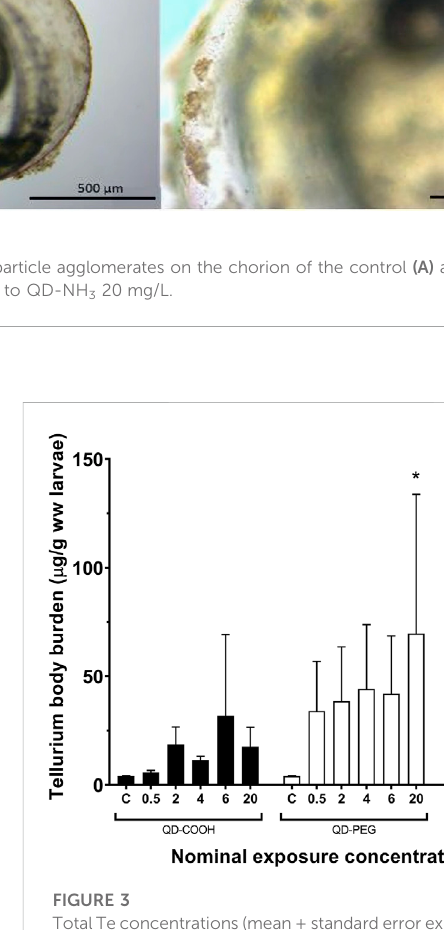
FIGURE 2 TotalCdconcentrations(mean±standarderrorexpressedasµg/ g ww larvae) in Danio rerio larvae after exposure to increasing concentrations of QD-COOH, QD-PEG and QD-NH 3 . Asterisk (*) indicates signi fi cance from control ( p < 0.05, T-tests).